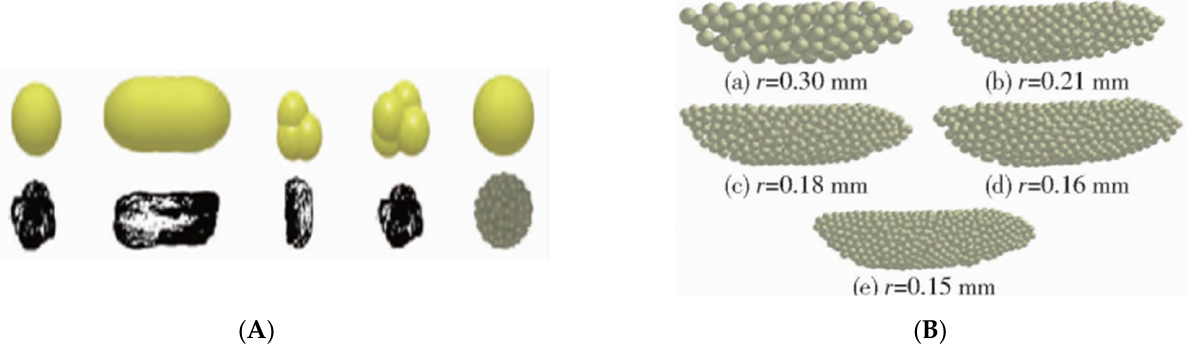
Figure 4. Discrete element contact mechanical models. ( A ) Soft sphere model. ( B ) Hard sphere model.